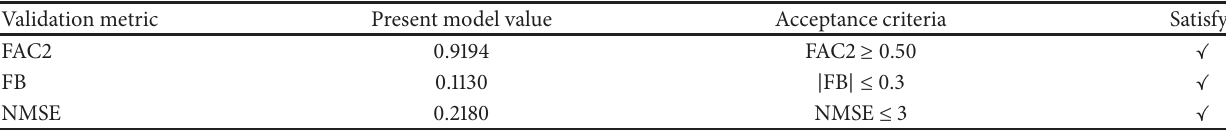
Table 2: Calculated values of the validation metrics from the LES results. The acceptance criteria for the model evaluation are adopted from